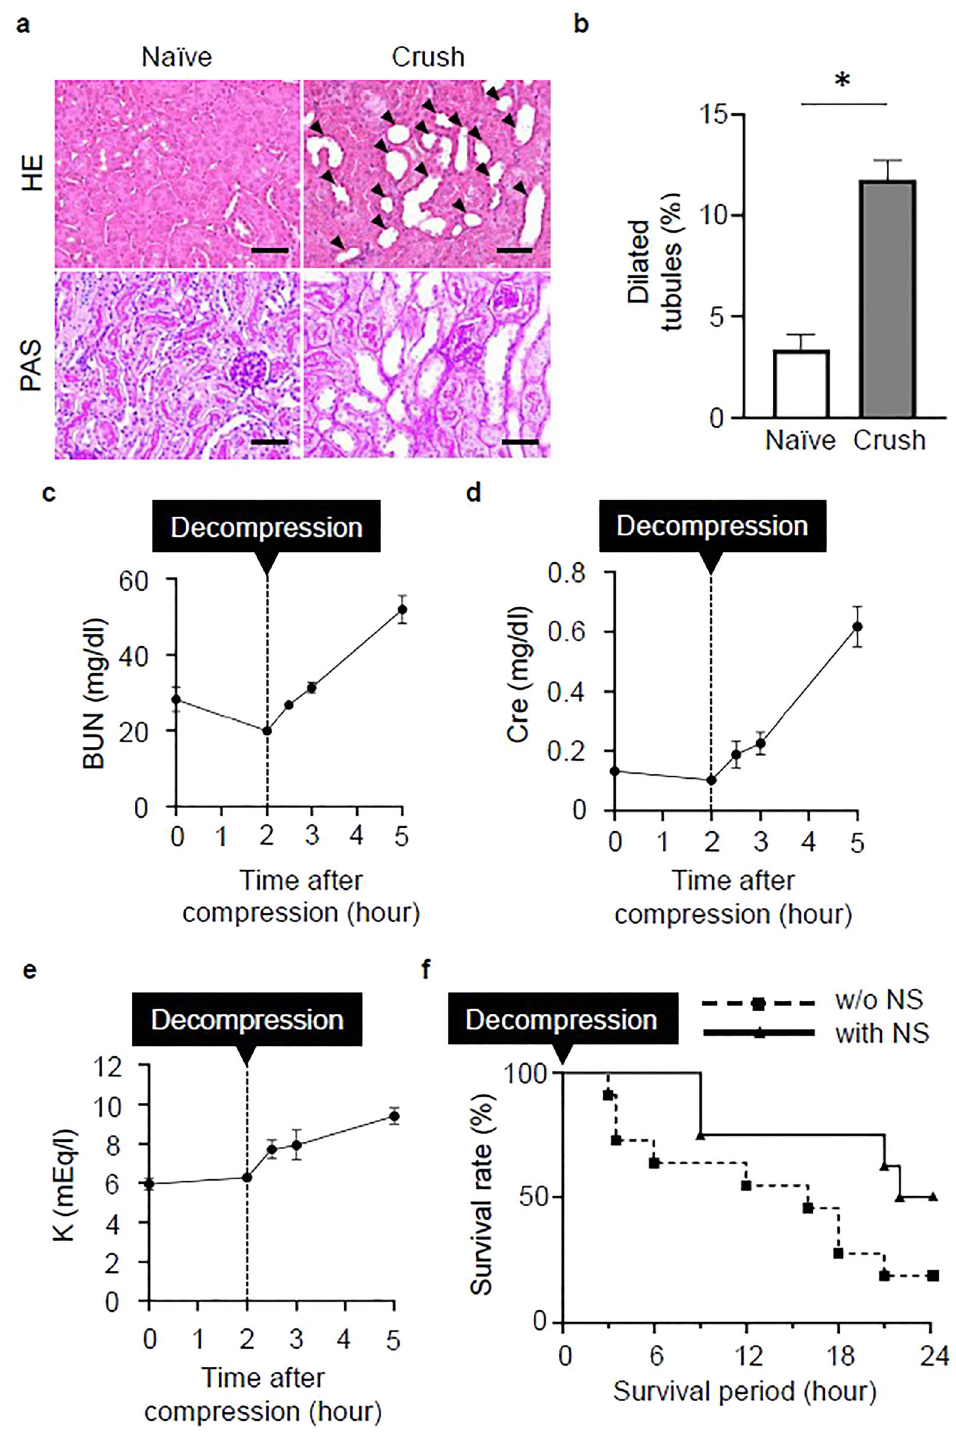
Figure 2. Crush syndrome leads to renal injury and fluid therapy improves the survival rate. ( a ) Representative images of HE and Periodic Acid Schiff (PAS)-stained renal tissue sections at 3 h post-reperfusion in the naïve and crush groups. Scale bars: 50 μm. ( b ) The quantitative analysis of the dilated tubules in the renal cortex in HE-stained sections from both groups (n = 4 per group). P < 0.05, unpaired t test. ( c – e ) Serum BUN, Cre, and K levels after reperfusion (n = 4 per group). BUN blood urea nitrogen, Cre creatinine, K potassium. ( f ) The post- reperfusion survival rates with/without normal saline (NS) treatment were calculated using the Log-rank test (Kaplan–Meier method). P < 0.05. CS crush syndrome, NS normal